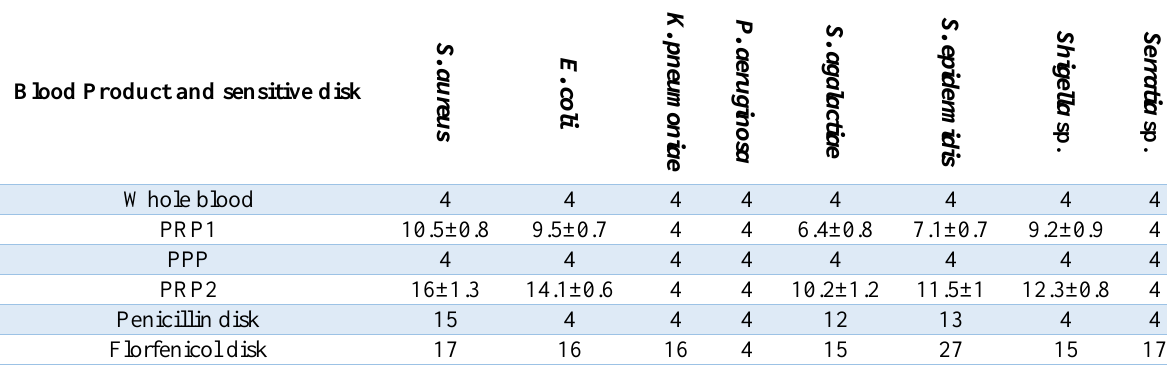
Table 2. Antibacterial Effect of PRP-2 in Different Concentrations of Platelets Name of